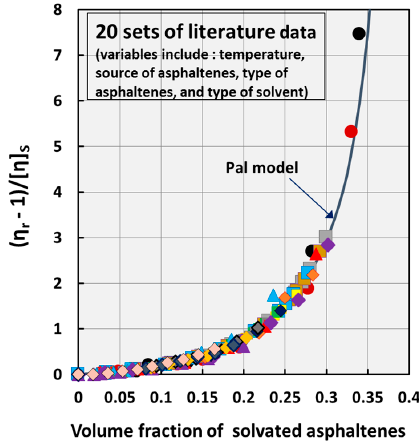
Figure 13. Twenty viscosity datasets of asphaltene suspensions plotted as ( η r − 1 ) / [ η ]